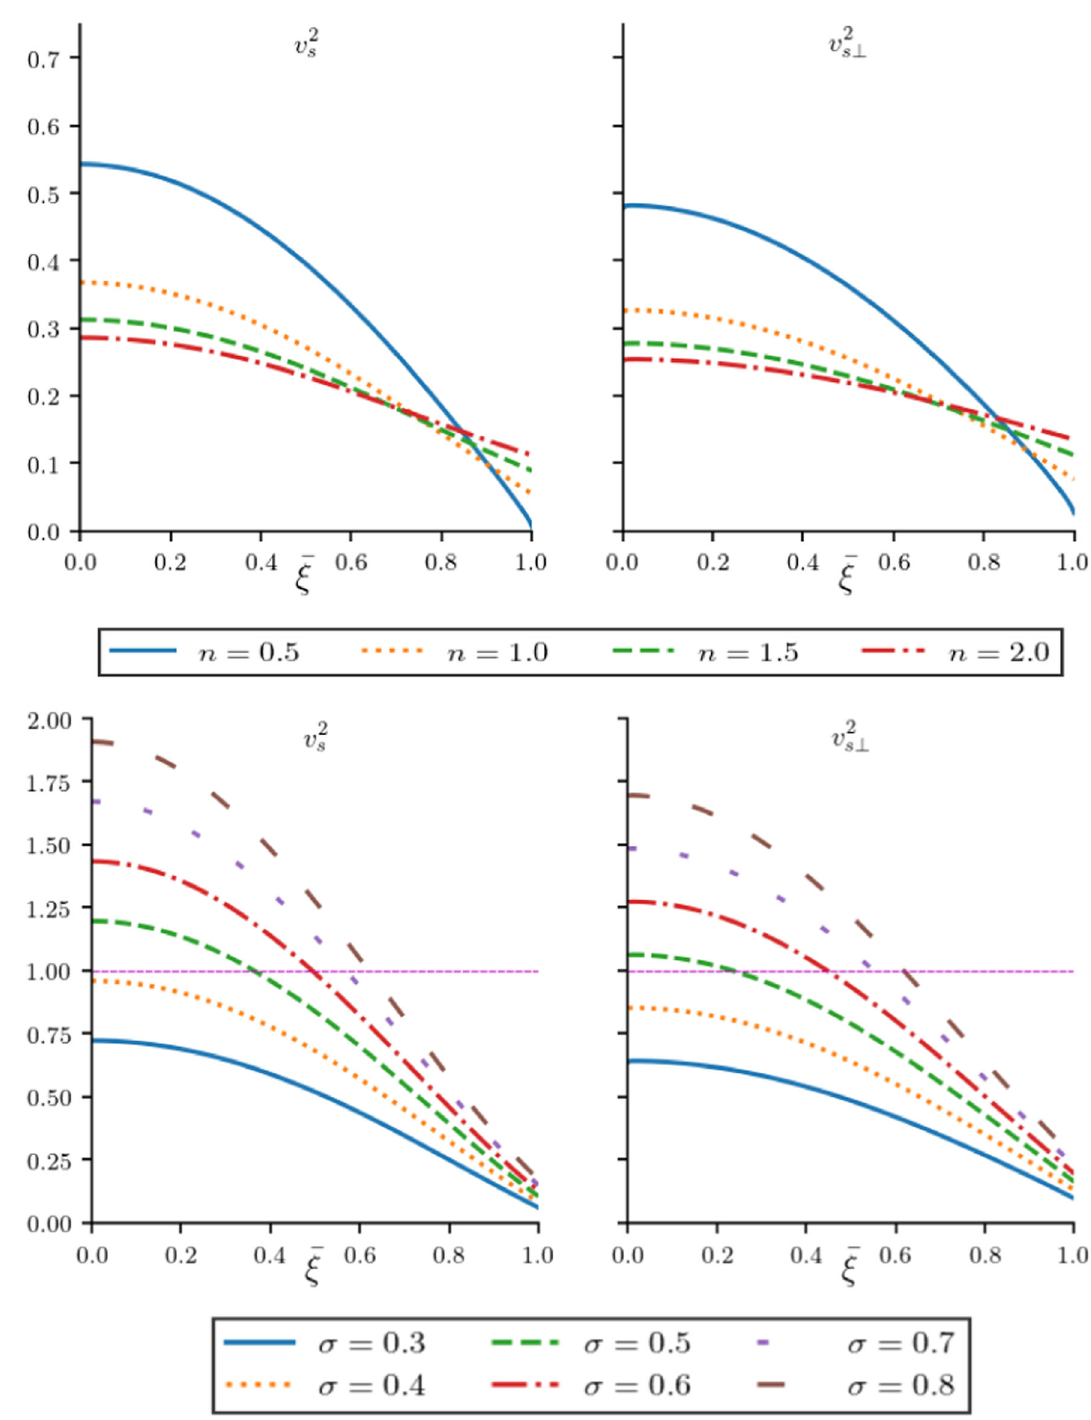
Fig. 4 Radial sound speed (left plates) and tangential sound speed (right plates) as a function of ¯ ξ for the Lane–Emden master equation, for models with parameters α = − 0 . 01, (cid:18) = 0 . 17 and C = 0 . 05. Top plates with σ = 0 . 175 and several values of n . Bottom plates with